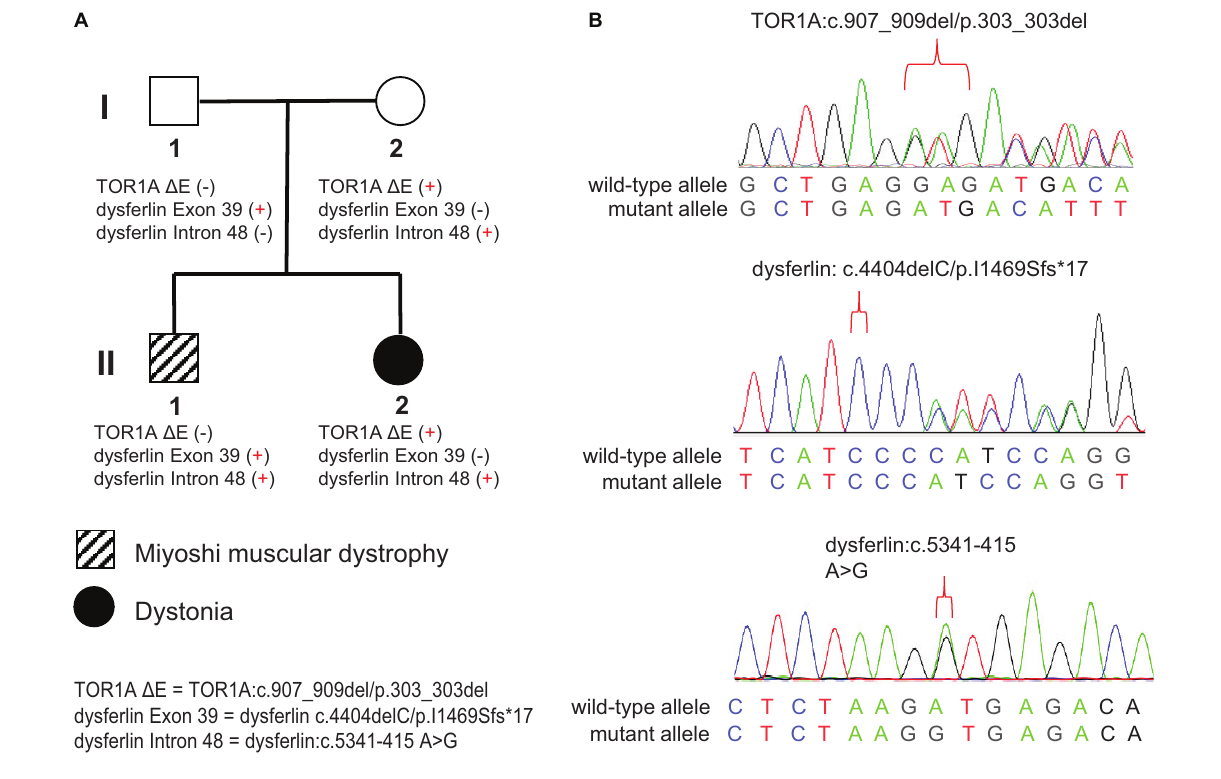
FIGURE 1 | Pedigree and Sanger sequencing chromatograms of the identified disease-causing variants. (A) Two different disease phenotypes were found within the same family, namely Miyoshi muscular dystrophy, which affected II-1, and dystonia, which affected II-2. II-1 harbored compound heterozygous variants in the DYSF gene (c.4404delC/p.I1469Sfs*17 and c.5341-415 A > G), derived separately from his parents. II-2 harbored the c.907_909del/p.303_303del variant in the TOR1A gene and the c.4404delC/p.I1469Sfs*17 variant in the DYSF gene, both of which were inherited from her mother. (B) Sanger sequencing chromatograms of the c.907_909del/p.303_303del variant in the TOR1A and the c.4404delC/p.I1469Sfs*17 and c.5341-415 A > G variants in the DYSF